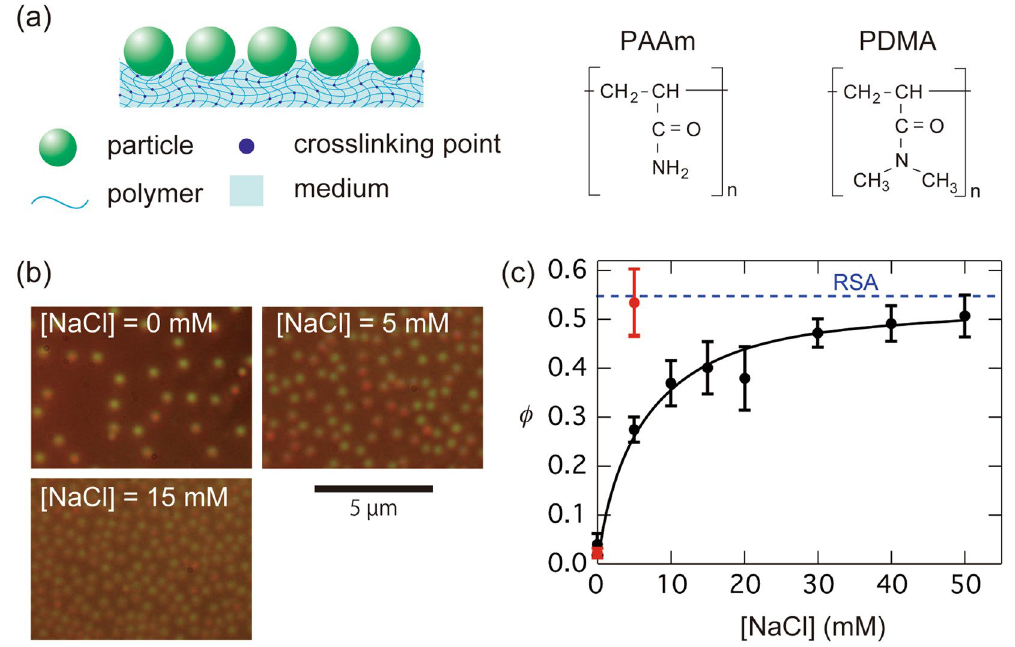
Figure 1. ( a ) An illustration of particle adsorption on polymer hydrogel surfaces, and the chemical structures of the two kinds of gel used. ( b ) Optical micrographs showing adsorbed colloidal silica particles (silica 1) on polyacrylamide (PAAm) gels in water at three different NaCl concentrations, [NaCl]. ( c ) Area fraction φ of the adsorbed silica particles in water plotted as a function of [NaCl] for PAAm and PDMA gels (black and red circles, respectively). Error bars represent standard deviations. The dashed horizontal line represents the maximum coverage ( = 0.547) for random sequential adsorption (RSA).